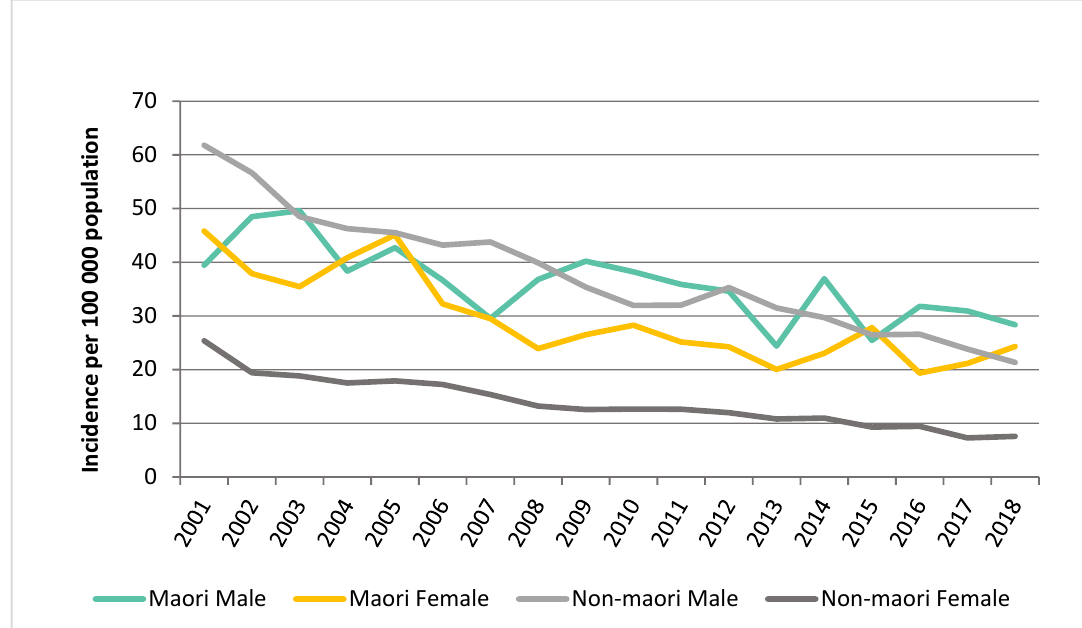
Figure 2. AAA hospitalisation age standardized to NZ population changes.